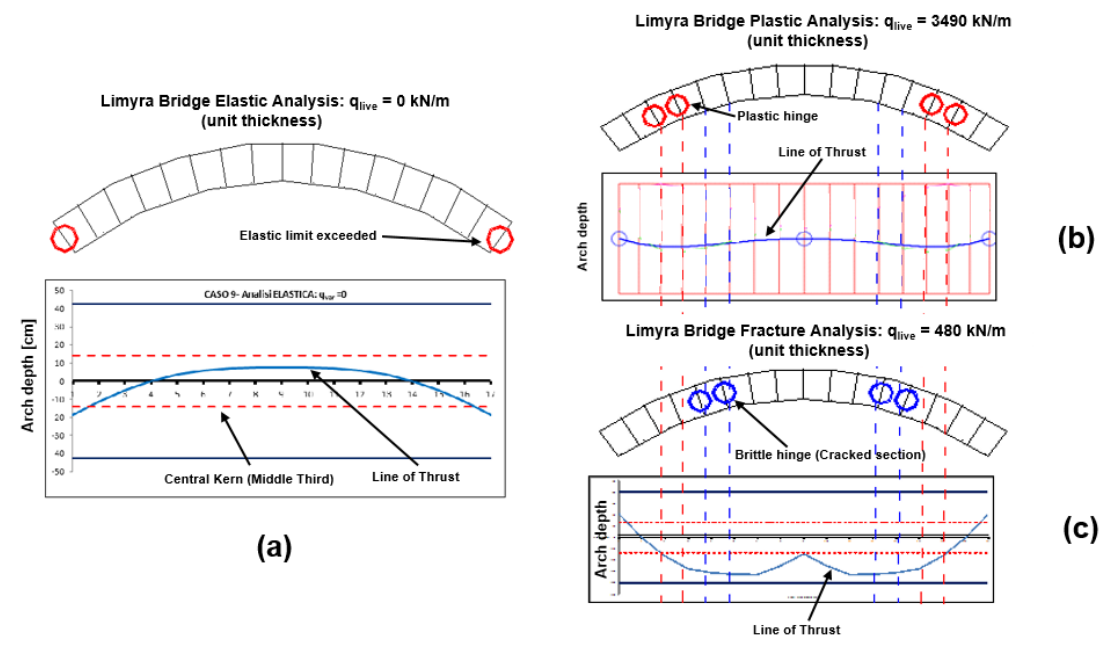
Figure 10. Limyra Bridge: ( a ) Elastic, ( b ) plastic, and ( c ) fracture analyses.